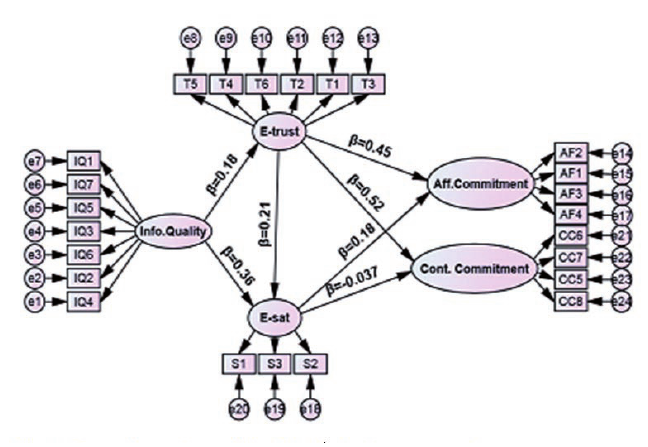
Fig. 2 - Structural equation modeling of the Study. Source: Authors Own